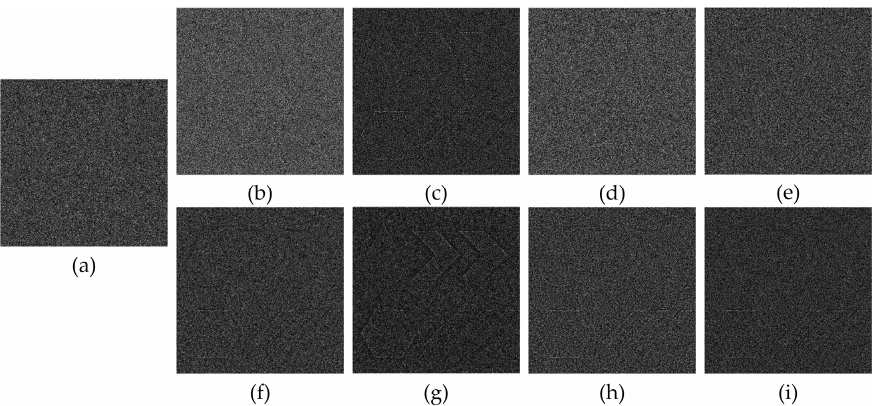
Figure 7. ( a ) Simulated true speckle noise. Ratio images between noisy and filtered images using ( b ) DPAD, ( c ) EnLee, ( d ) SAR-BM3-D, ( e ) FANS, ( f ) PPB, ( g ) DnCNN, ( h ) NL-means, and ( i ) MDLPIA- NLM